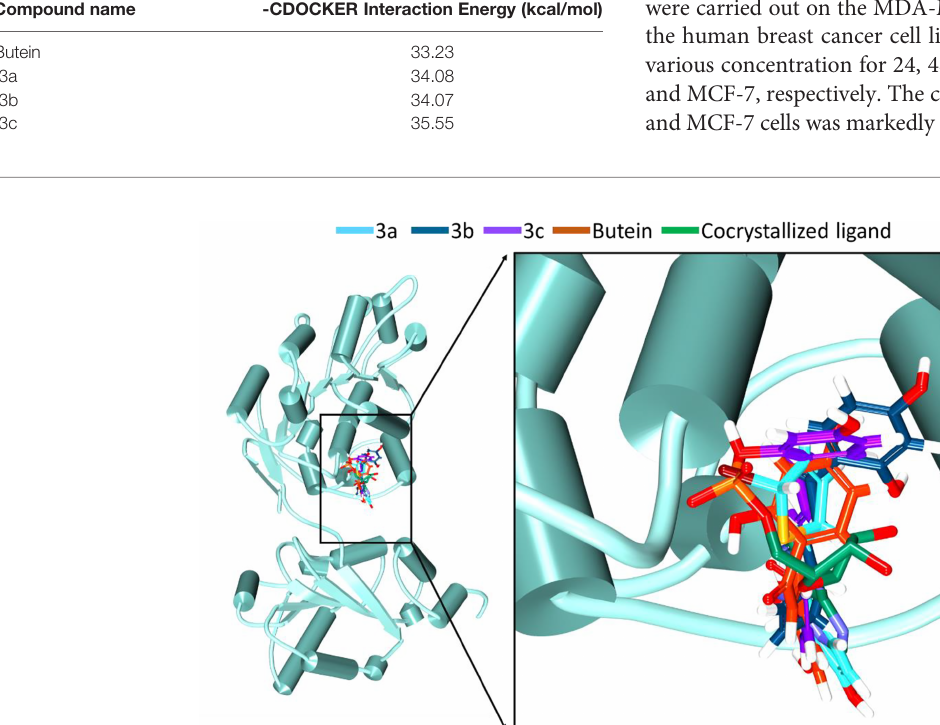
TABLE 1 | Molecular dock score of butein and its analogues with target DDX3.